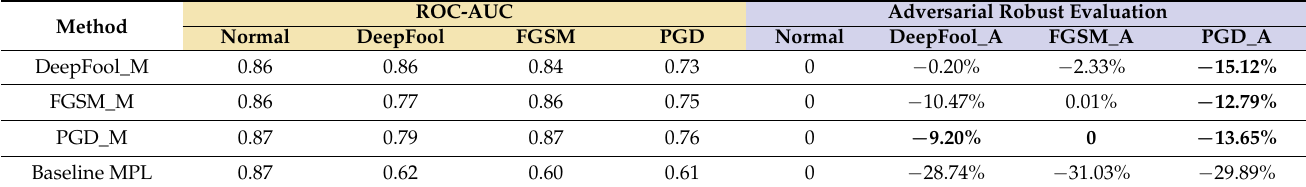
Table 8. Adversarial attacks evaluation on adversarial-trained models.